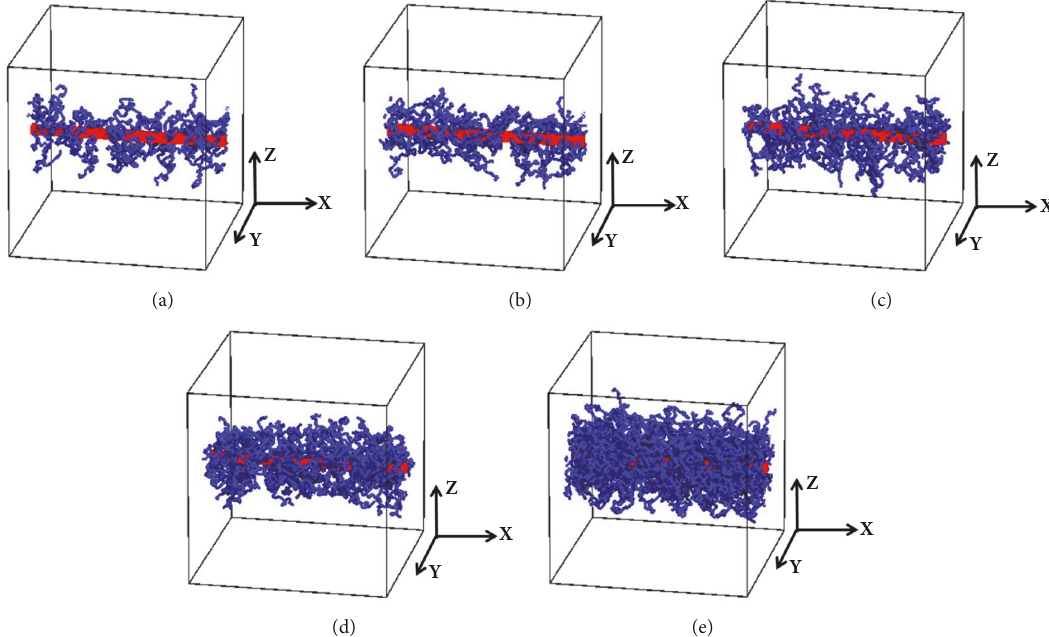
Figure 3: Relaxed polymer systems with 52(a), 64(b), 84(c), 128(d), and 252(e) polymer chains. Blue cylinders denote the polymer chains, and red parts represent the nanorod.